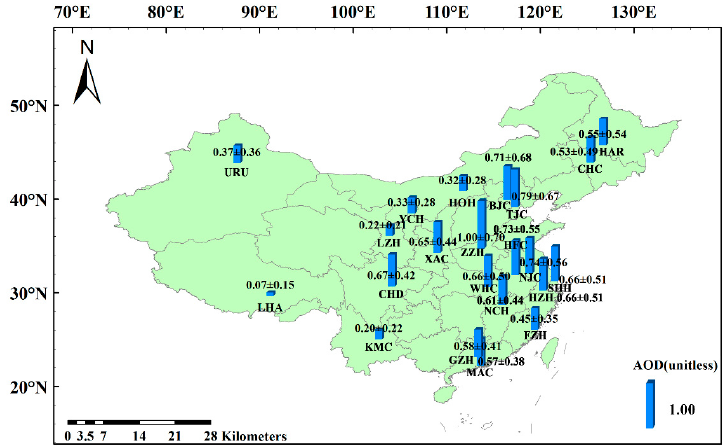
Figure 3. Spatial distribution of the annual average AOD over China from 2014 to 2015. The blue pillars represent AOD, and the height of blue pillars represent the average annual AOD (unitless). Table 1. The descriptive statistics of PM 2.5 (annual average value ± standard deviation, unit: µ g/m 3 ) and AOD (annual average value ± standard deviation, unit: unitless), the linear regression function and the Pearson correlation coefficient (R) of PM 2.5 and AOD, and the data groups (N) involved in the calculation throughout China from 2014 to 2015 are shown, combined with the abbreviations, locations (unit: degree) and terrain height (unit: m) of selected provincial capitals. Provincial